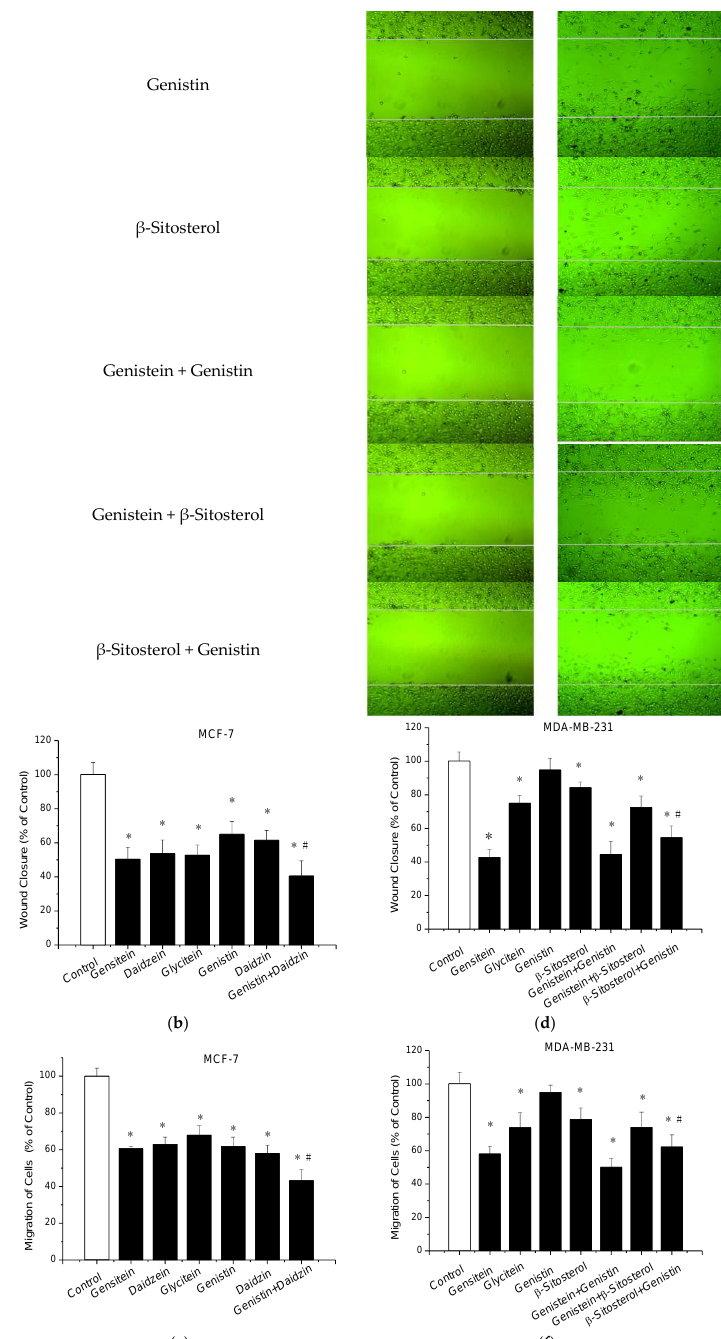
Figure 4. Inhibition of cell invasion and migration measured by wound healing assay and transwell chamber assay. For wound-healing assay, wounds were made when cells were 90–100% confluent. Overnight, cells were treated with samples, or control. The closure of wounds in MCF-7 cells and MDA-MB-231 cells were imaged ( a , c ) and quantitatively measured ( b , d ) at 0 h and 24 h. For transwell chamber assay, MCF-7 ( e ) and MDA-MB-231 ( f ) Cells were treated with samples, or control for 48 h. Cells suspended in serum-free medium were seeded on the upper membrane of transwell chamber and incubated for 48 h. Complete growth medium was added on the bottom. Cells on the lower membrane of chambers were counted. Data are presented as mean ± SD. * indicates a significant difference compared to the control ( p < 0.05). # indicates a significant difference compared to treatment with samples by single ( p < 0.05). Results of the transwell assay showed that gensitein, daidzein, glycitein, genistin and daidzin have a positive effect on MCF-7 cell migration (Figure 4e). The migration of MCF-7 cells was respectively inhibited by 65.43%, 57.04%, 42.04%, 38.19% and 62.03% with gensitein, daidzein, glycitein, genistin and daidzin treatment compared to control. The combination treatment of genistin plus daidzin significantly enhanced ( p < 0.05) the inhibition compared to genistin and daidzin alone. The inhibitory effects of genistein, glycitein, genistin and β-sitosterol on MDA-MB-231cell migration were also examined (Figure 4f). Similar to results of the wound-healing assay, genistein, glycitein, genistin and β-sitosterol led to a significant decrease ( p < 0.05) in MDA-MB-231 cell migration, however, genistin had no significant effect by single treatment. Three combination treatments also showed significant inhibitory effects on MDA-MB-231 cell migration, however, only combination of genistin plus β-sitosterol enhanced the effects compared to genistin and β-sitosterol alone. Overall, all the data indicate that the bioactive anticarcinogens, except genistin, from soybean effectively decreased the invasive and migratory ability of MCF-7 cells and MDA-MB-231 cells. The combination treatment could enhance the inhibitory effect. The inhibitory effect on the invasion and migration of cancer cells is not due to the cytotoxicity. 2.4. Modulations of Protein Expression and Signaling Pathways The anti-proliferative effect and inhibitory effect on cell invasion and migration of anticarcinogens was associated with changes in multiple signaling pathways [14]. In order to explore the involved signaling pathways of single treatments and combination treatments in MCF-7 and MD-MB-231 cells, the protein expression levels of 18 intracellular signaling molecules (Figure 5a) were examined. In MCF-7 cells (Figure 5b,c), results showed that genistein significantly ( p < 0.05) decreased phosphorylation of stat3, Akt, and PRAS40; Daidzein significantly ( p < 0.05) decreased phosphorylation of stat3 and PRAS40; Glycitein significantly ( p < 0.05) decreased phosphorylation of stat3, and increased phosphorylation of 5′AMP-activated protein kinase (AMPK) α; Daidzin